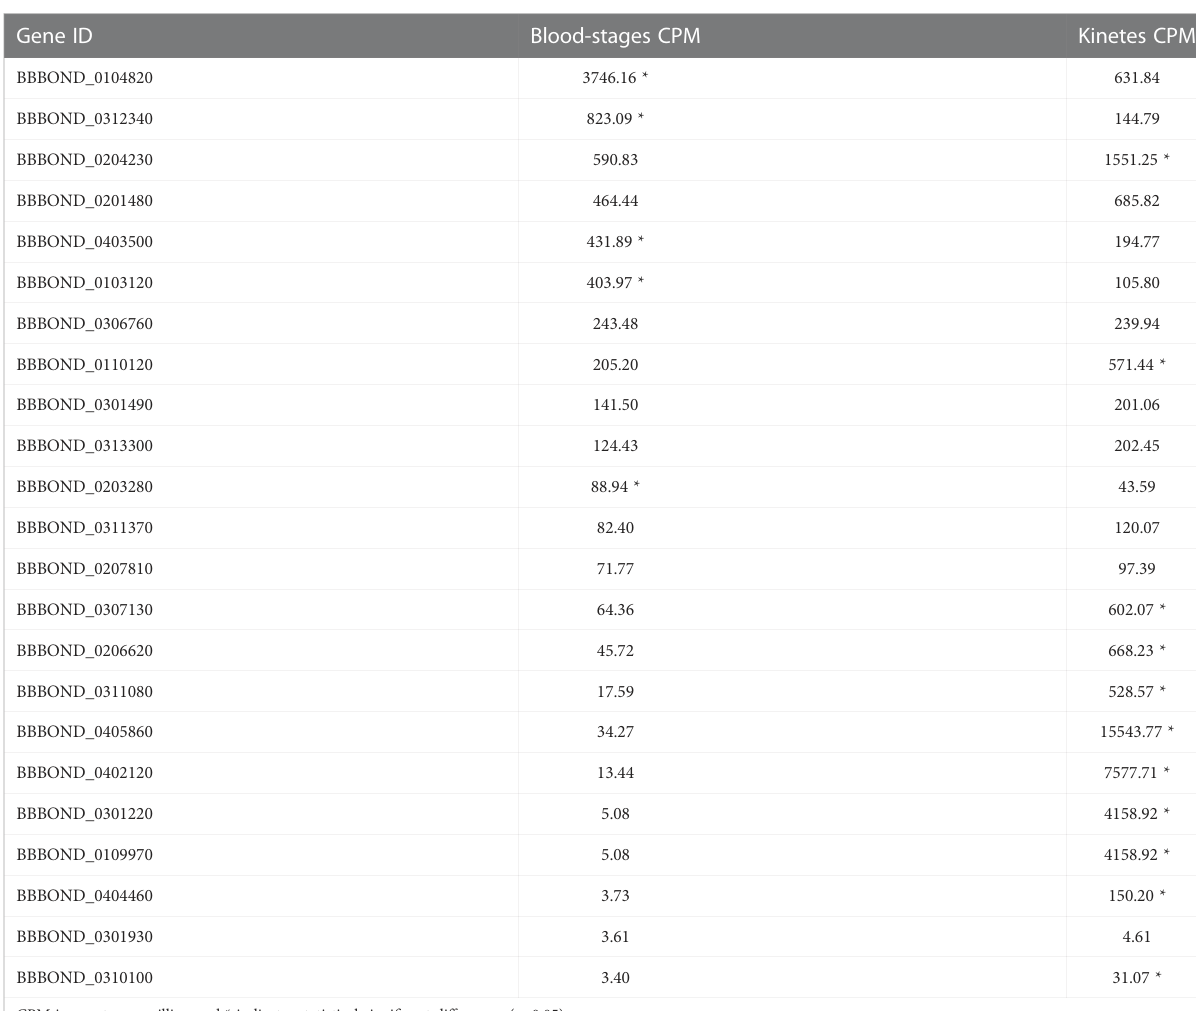
TABLE 5 AP2 gene family expressed in blood-stages and in kinetes in B. bigemina . Gene